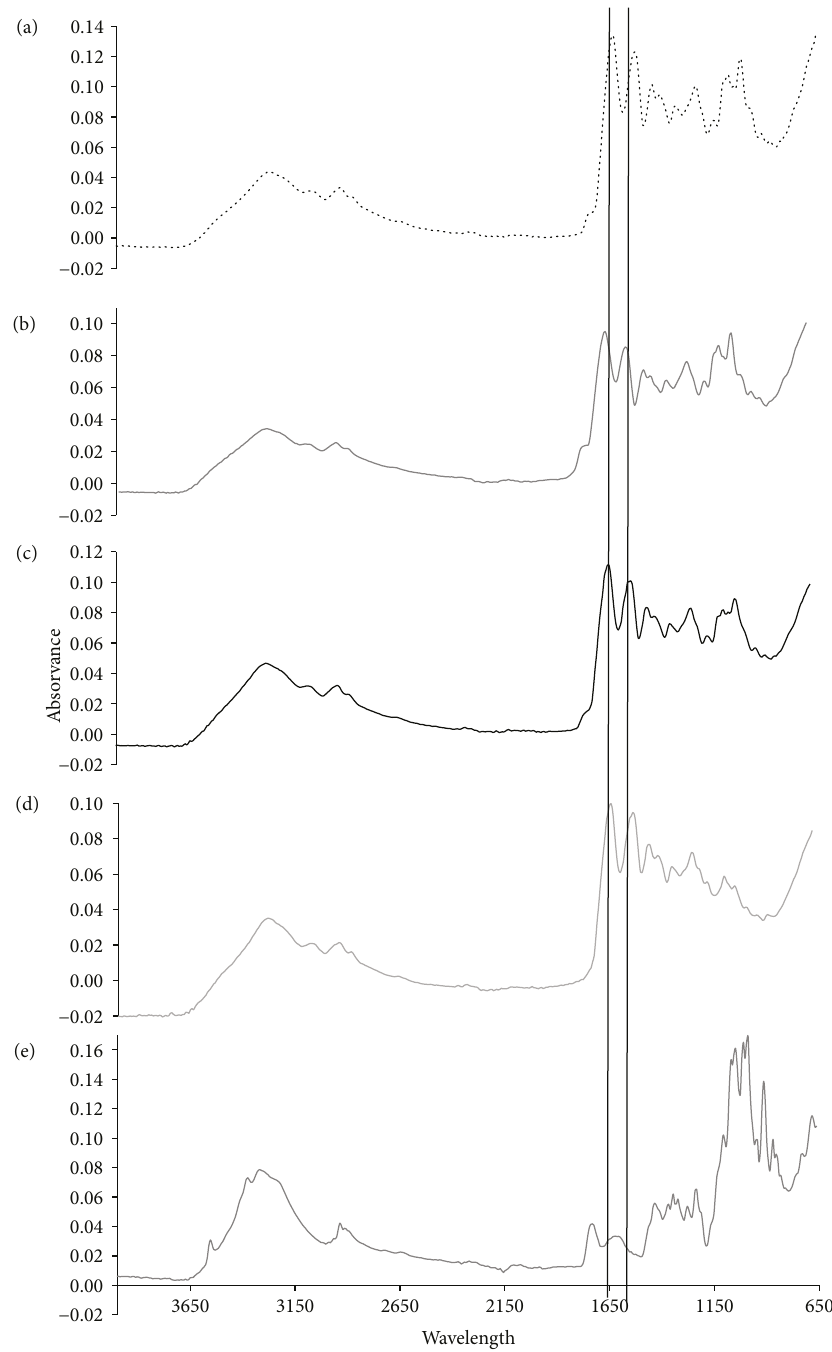
Figure 9: FTIR spectra of hydrogels. Absorbance is a wavelength function. The spectra shown in Figure 8 are (a) H.6.20 (6% HOP and 20% of gelatin), (b) L.6.20 (6% LOP and 20% of gelatin), (c) N.6.20 (6% NOP and 20% of gelatin), (d) 0.20 solely gelatin (20% gelatin), and (e) solely native